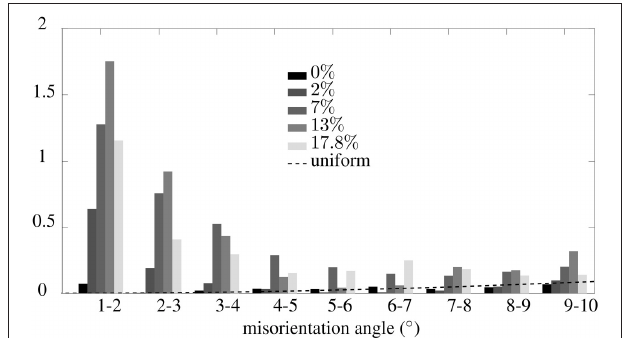
FIGURE 8 | Distribution of misorientations measured between adjacent pixels, extracted from the 50 µ m resolution EBSD data from Figure 5, for the tests performed up to 2, 7, 13, and 17.8% strain. The dash line provides the case of a uniform distribution of misorientations in the considered range. The y-axis scales as the density normalized such that sum over densities = 100 over the full range of misorientations considered (0–93 ◦ )